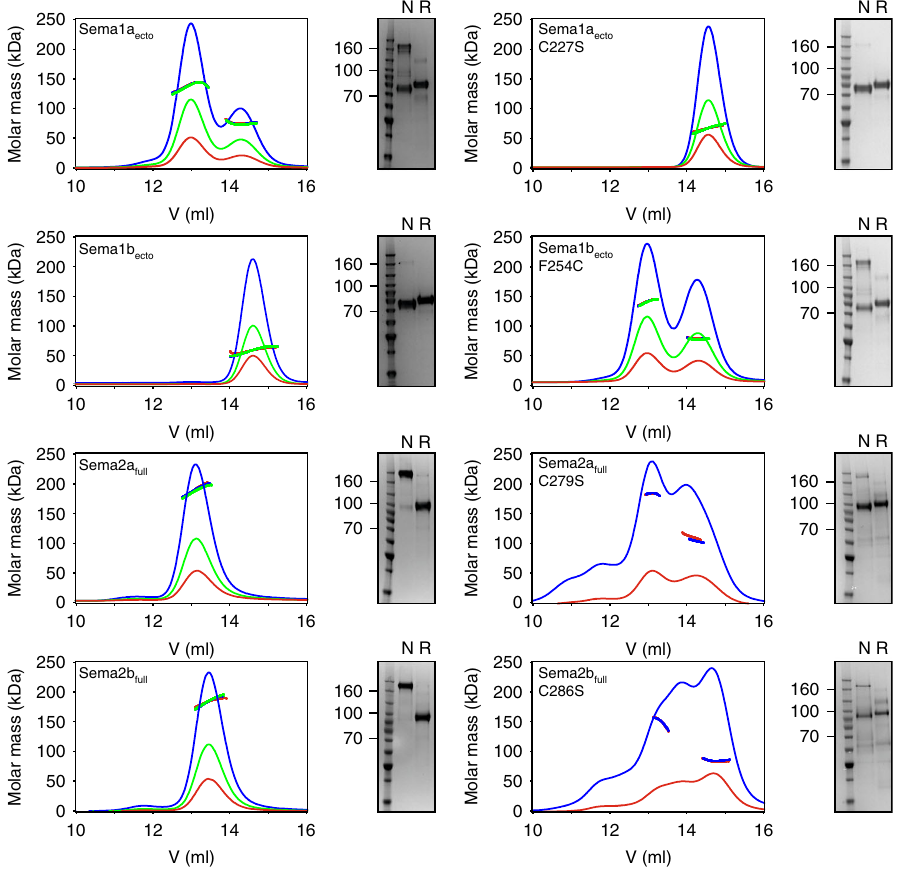
Fig. 2 MALS and SDS-PAGE of Drosophila class1 and class 2 semaphorins. Drosophila semaphorins (left panel) were analysed using size-exclusion chromatography with multi-angle light scattering (MALS) and SDS-PAGE under reducing (R) and non-reducing (N) conditions. Sema1a ecto is a mixture of a monomer and a dimer in solution, and SDS-PAGE indicates that the dimer is disul fi de-linked. Sema2a full and Sema2b full appear to be exclusive disul fi de- linked dimers in solution. For Sema1b ecto , MALS indicates an experimental molar mass of 75 ± 0.3 kDa, which is in agreement with the theoretical molar mass for a monomer (70 kDa). No peak shift towards higher molecular masses is observed at any of initial protein concentrations of 2.0 (blue), 1.0 (green), and 0.5 mg/ml (red). Mutation analysis (right panel) indicates that class 1 and 2 semaphorins differ in their propensity to dimerize non-covalently. Source data are provided as a Source Data fi